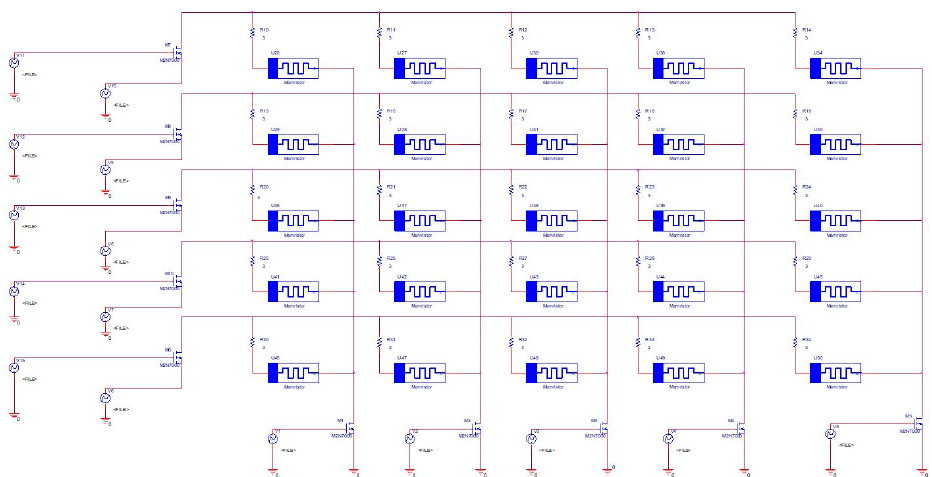
Figure 4. A fragment of the memristor-based hybrid memory matrix. Electronics 2019 , 8 , 383